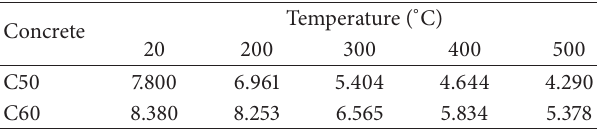
Table 5: The flexural strength of HPC at elevated temperature (MPa).